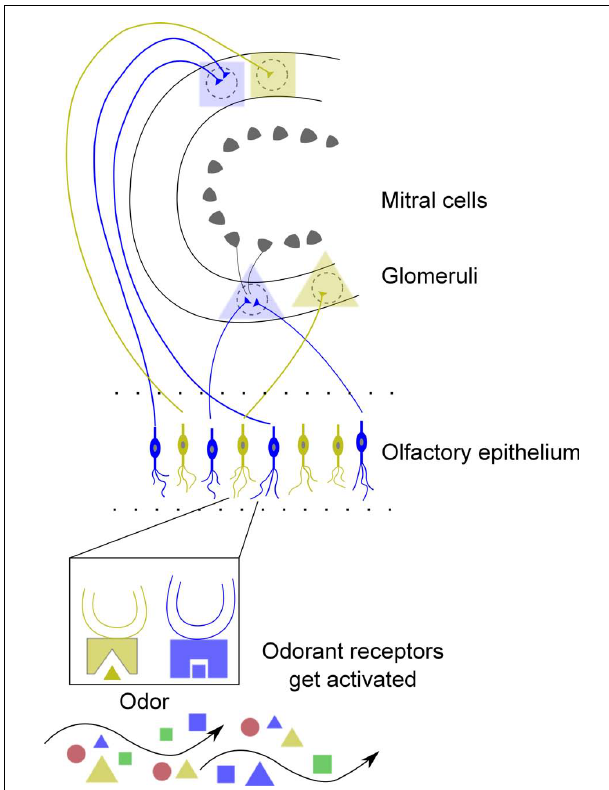
FIGURE 1 | Schematic of the early olfactory system including the olfactory epithelium and bulb. Each ORN expresses one OR which responds to different odorants (see Figure 2 ). In the first step of the sensory pathway, odorant molecules bind to ORs in the olfactory cilium which activate ORNs in the epithelium which in turn transduce the input signal into action potentials. ORNs expressing the same OR generally project to the same glomerulus (Bozza et al., 2002; Mombaerts, 2004) and connect to the principal neurons of the OB, the mitral, and tufted cells (MT cells).These principal neurons forward their output to higher-order brain regions. Bulbar interneurons, granule cells (not shown) receive lateral inhibition and feedback from piriform cortex (Haberly and Price, 1977).The colors and symbols indicate molecular features of odorants and a chemotopic convergence from ORN axons to glomeruli. According to odotope theory (Shepherd, 1987; Mori, 1995), individual MT cells transmit information about a range of odor molecules with related molecular structures (so called odotopes). Cleland et al. (2007) and Johnson and Leon (2000) argued that qualitative odor perception is determined by glomerular activity patterns.They described also that different glomerular activity patterns, elicited, e.g., by increased concentration can lead to qualitatively different odor